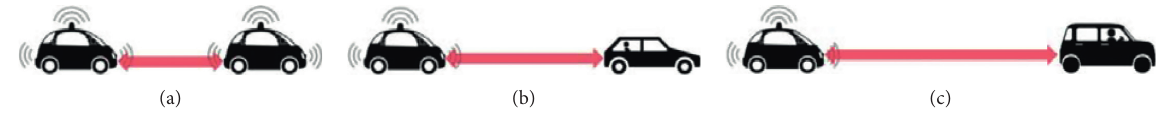
Figure 4: The relative implemented distance between a CAV and (a) CAV, (b) AV, and (c) HV